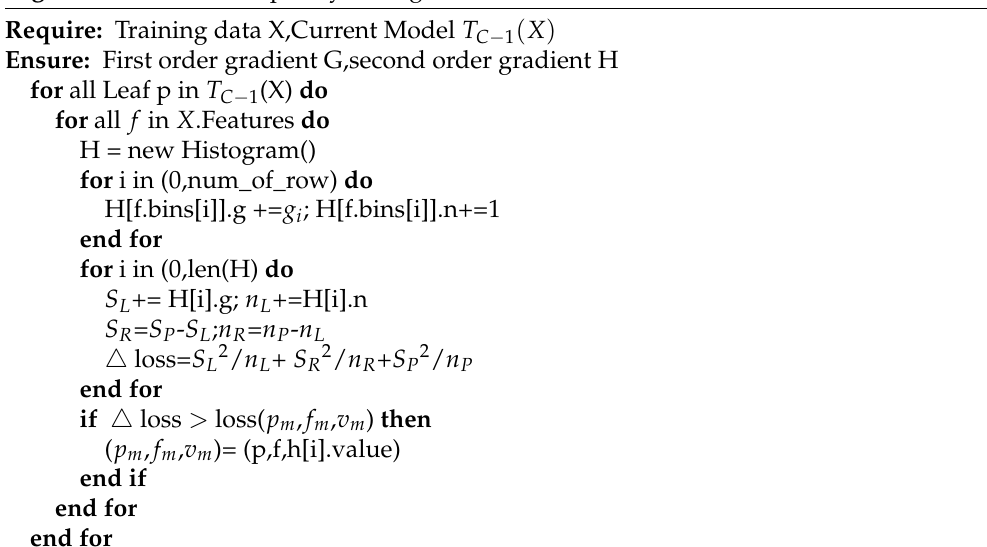
Algorithm 1 Find Best Split By